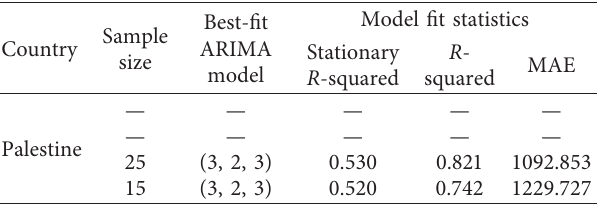
Figure 4: Road crash time-series for Palestine (1971–2015). Table 7: The selected best-fit models for each sample size for Palestine.